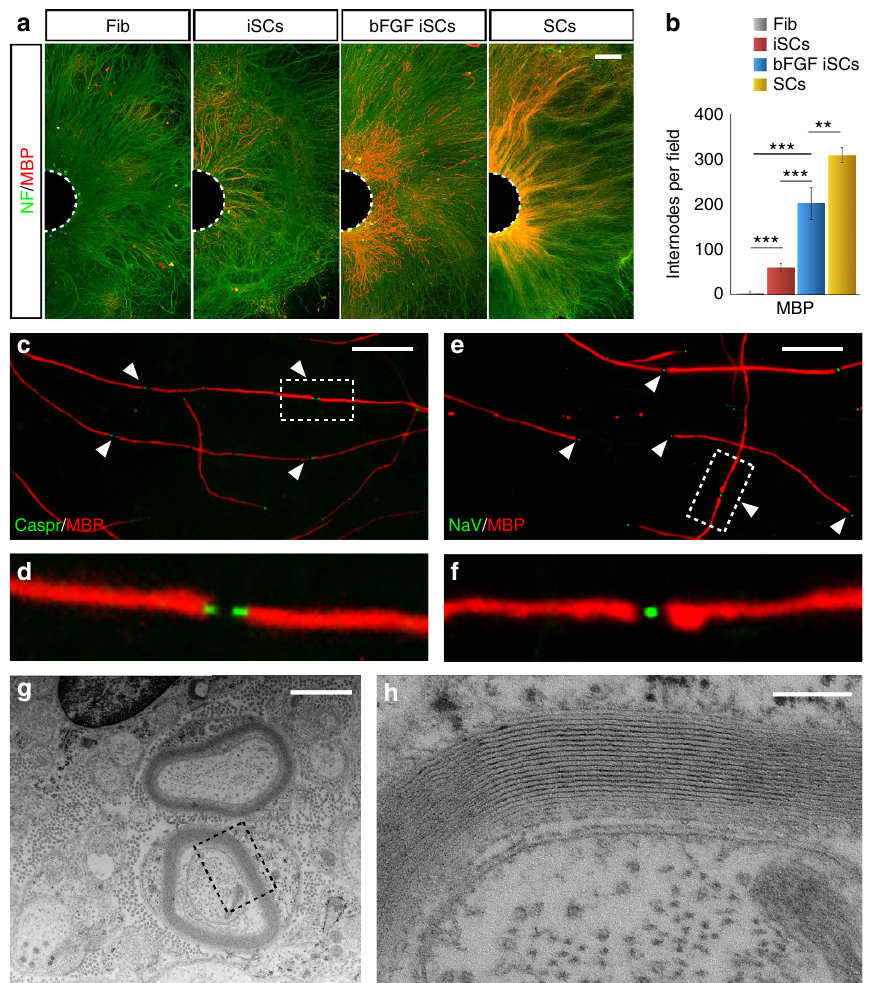
Figure 4 | In vitro myelination properties of iSCs. ( a ) Myelin generated by fibroblasts (Fib), iSCs with or without bFGF retreatment and somatic SCs plated on mouse DRG axons as visualized by immunofluorescence for MBP (internodes, red), and Neurofilament (NF, green) at 2 weeks of co-culture. ( b ) Quantification of the myelin internodes generated by the four different cells types after 2 weeks of co-culture with DRG neurons (Mean ± s.d., n ¼ 4 independent experiments, 4–8 coverslip/experiment, 10 randomly selected 20 (cid:2) fields per coverslip were examined). ( c , d ) Representative immunofluorescence staining for MPB þ internodes together with Caspr ( c ) or NaV ( d ) to visualize the paranodal (arrowsheads) and nodal (arrowheads) regions, respectively, at 4 weeks of iSCs with DRG neurons co-cultures. ( e , f ) High-magnification fields of the boxed area in c , d , respectively. ( g , h ) Representative electron microscopy pictures of myelinated iSCs at 4 weeks of co-culture. ( h ) Is a high-magnification image of the boxed area in e . ** P o 0,01; *** P o 0,001; One-way ANOVA with Bonferroni correction. Scale bars, 500 m m ( a ), 50 m m ( c , d ), 1 m m ( e ), 100nm (